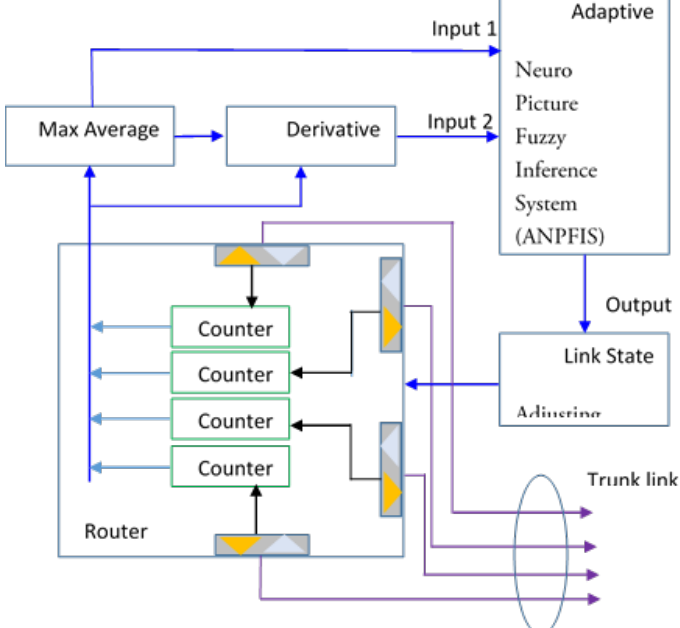
Fig. 4. The architecture of the trunk link state controller based on